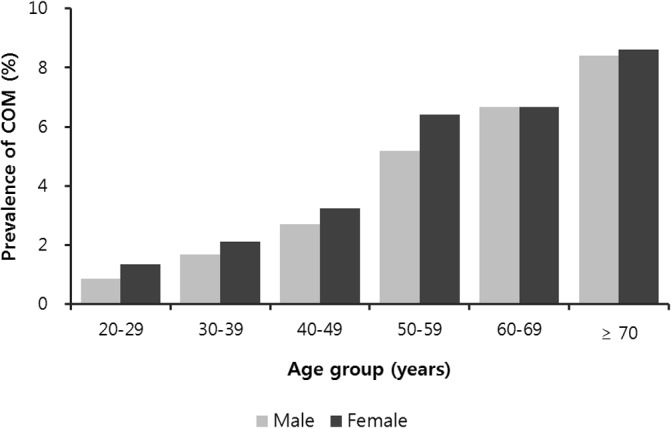
Prevalence of chronic otitis media by age group and sex in Korean adults.The prevalence of chronic otitis media increased with age in both sexes.